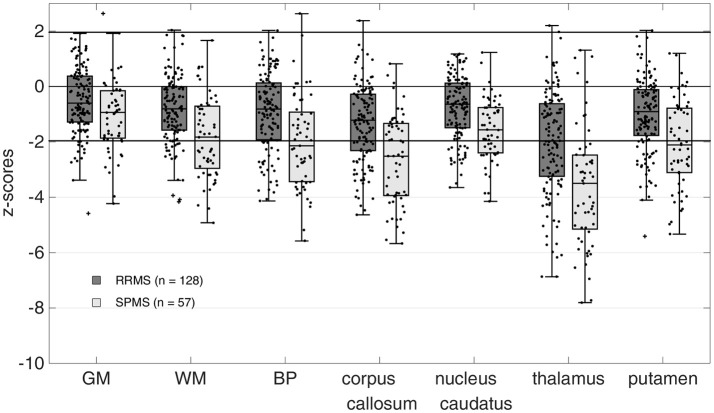
Z-scores of calculated brain volumes. Brain volumes were normalized to the respective scanner-specific control cohort. Z-Scores for all regions were significantly different from zero (p < 0.0001 for all brain regions). Mean z-scores for the thalamus were significantly lower than all other brain volumes (p = 0.0295 for comparison with corpus callosum, p < 0.001 for all other comparisons, ANOVA with Bonferroni correction) in both the relapsing-remitting MS (RRMS) and secondary progressive MS (SPMS) patients. GM, gray matter; WM, white matter; BP, brain parenchyma.